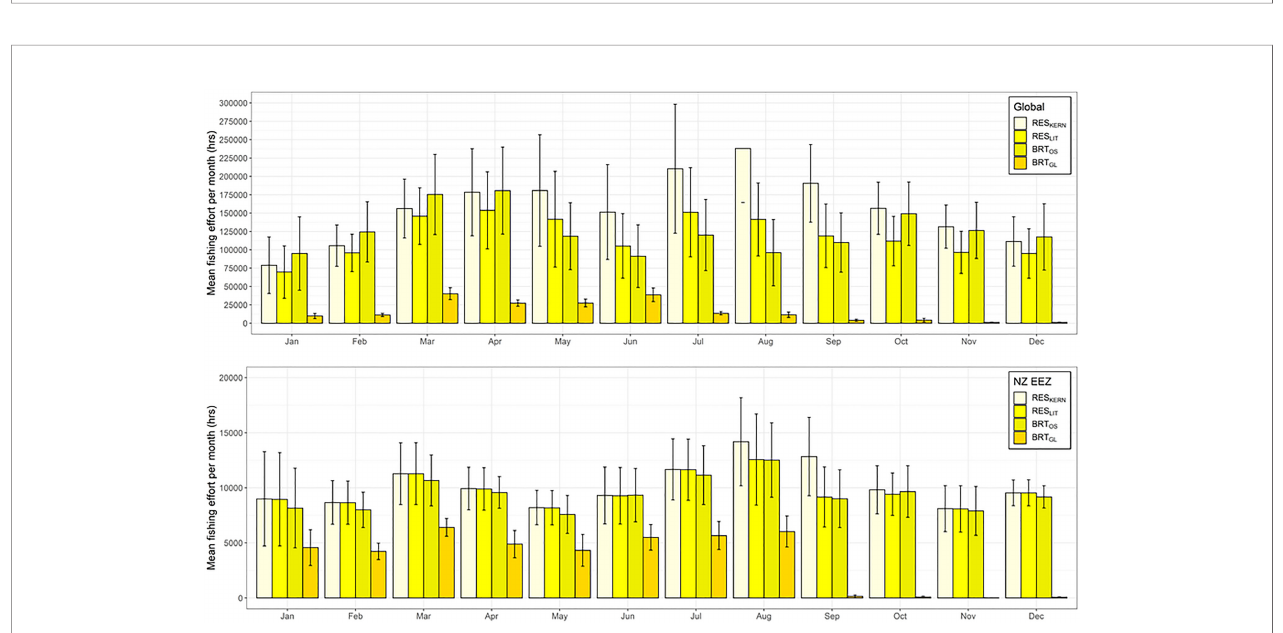
FIGURE 5 | Mean total fi shing effort (hrs) (based on data from Global Fishing Watch) per month that occurs within the predicted preferred habitat of Buller ’ s albatross both globally (top) and within New Zealand ’ s Exclusive Economic Zone (bottom). Colour coding denotes different habitat suitability models and error bars indicate one standard